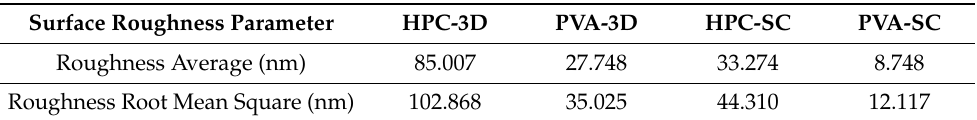
Table 3. Morphological characteristics with the surface roughness of orodispersable films (3D, 3D printing; SC, solvent